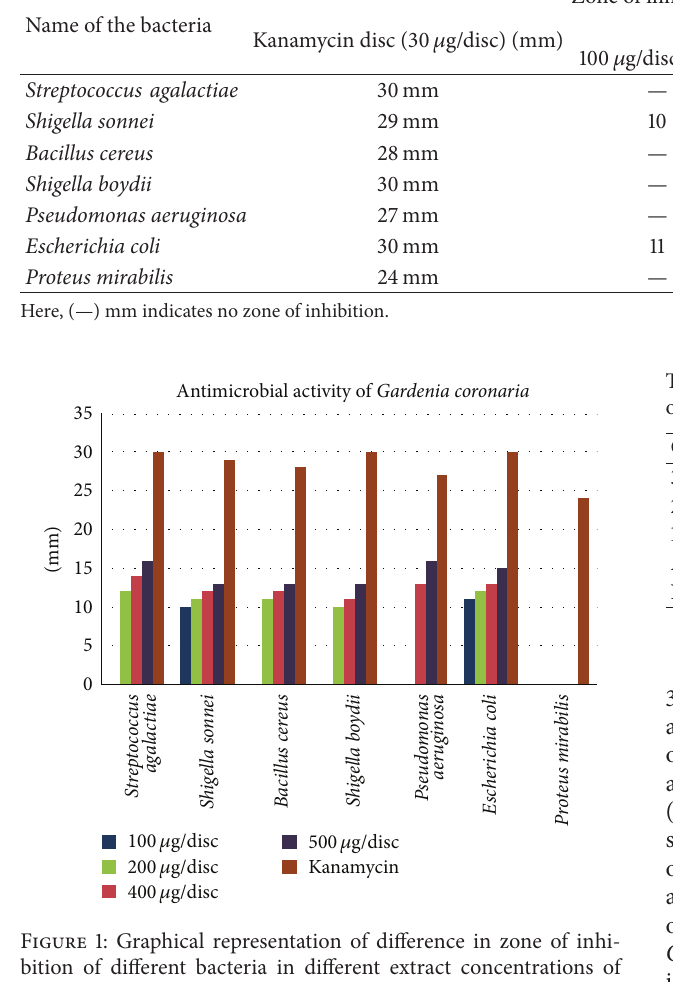
Table 2: The zones of inhibition against selective bacteria by Methanolic extract of Gardenia coronaria leaves. Name of the bacteria